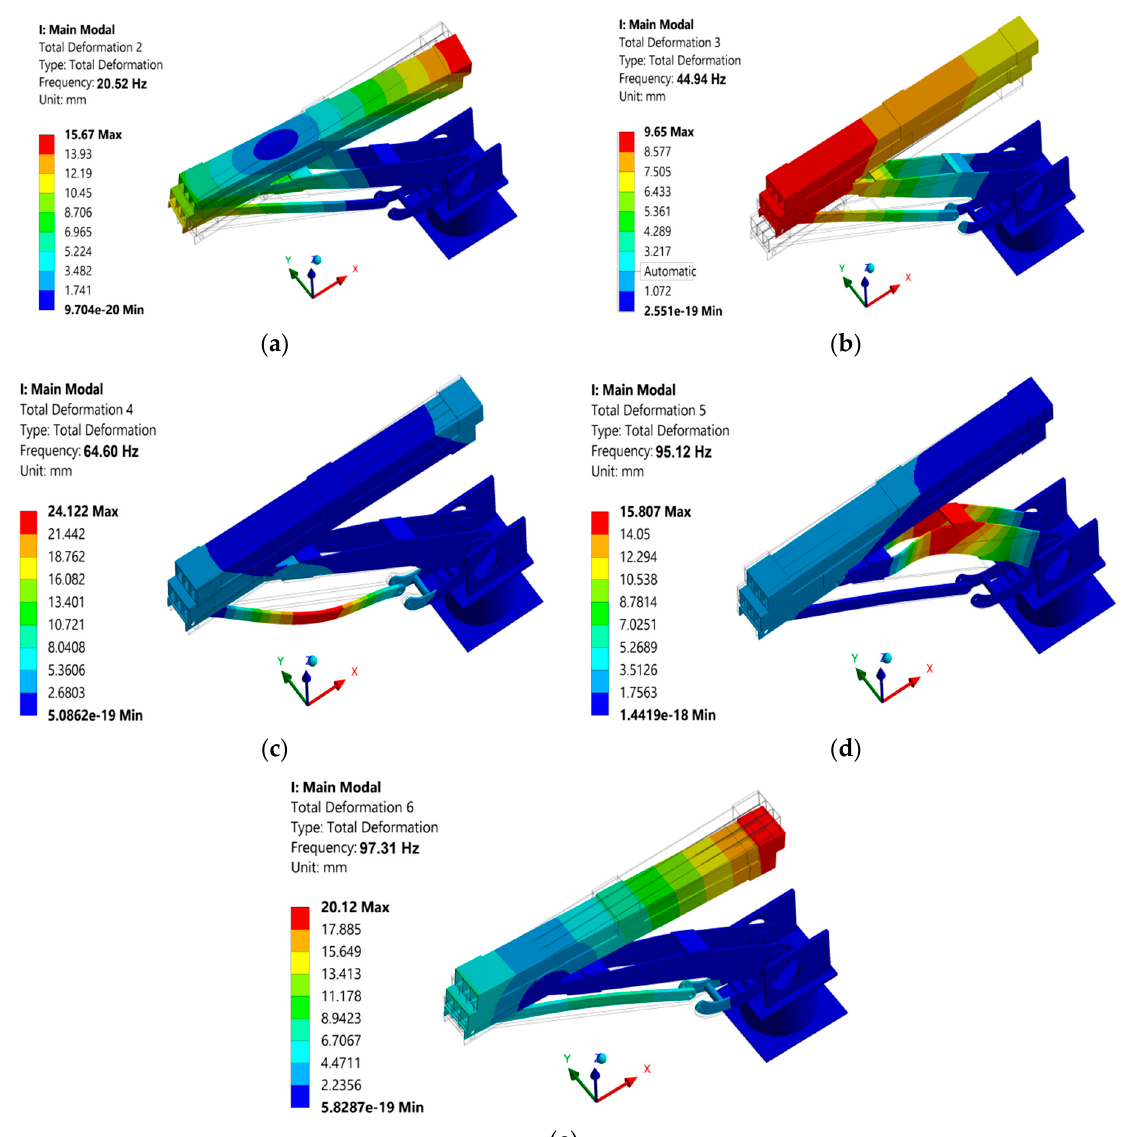
Figure A1. Natural frequencies and corresponding mode shapes for the CFRP 5 ‐ DOF manipulator in Configuration 1: ( a ) second frequency, ( b ) third frequency, ( c ) fourth frequency, ( d ) fifth fre ‐ quency, and ( e ) sixth frequency.